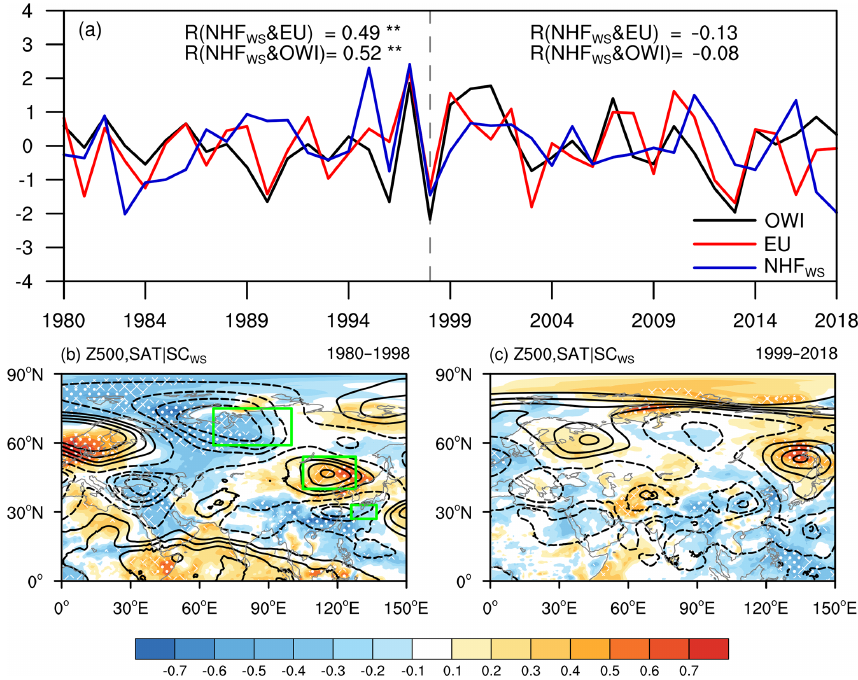
Figure 6. (a) The normalized variation in the JJA OWI (black), JJA EU index (red) and AM NHF WS (blue) from 1980 to 2018 after detrending. The numbers represent the correlation coefficients between NHF WS and EU and between NHF WS and OWI during 1980–1998 and 1999–2018, respectively. Two asterisks indicate that the correlation coefficients exceeded the 95% confidence level. The correlation coefficients between SC WS ×− 1 and JJA surface air temperature (shading) and geopotential height at 500hPa (contour) from 1980 to 1998 (b) and from 1999 to 2018 (c) are shown. The white dots (hatching) indicate that the correlation coefficients with surface air temperature exceeded the 95% (90%) confidence level ( t test). The green boxes represent the key areas used to calculate the EU index. The linear trend is